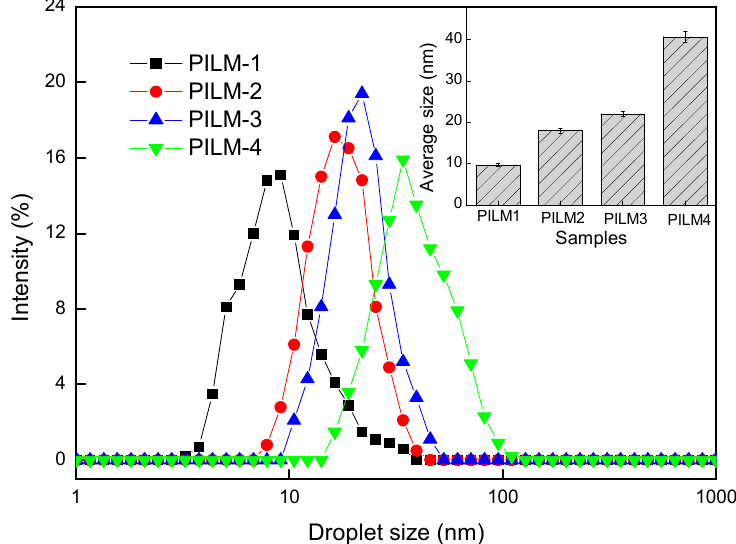
Figure 1. Size and size distribution of the [AMIM][Cl]/[AMIM][PF 6 ]/PEGDA/HAPS microemulsion with different amounts of PEGDA.